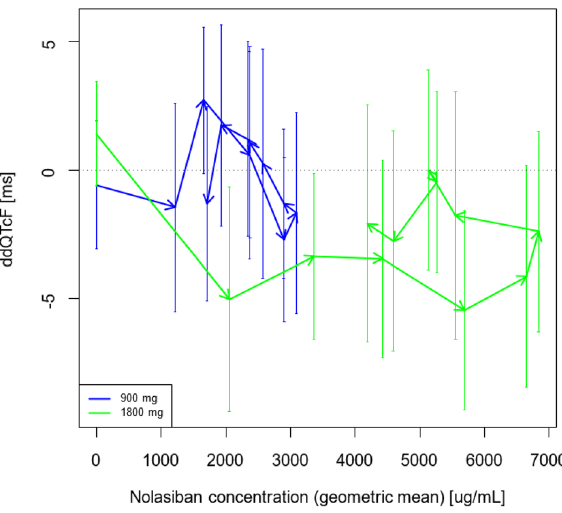
Figure 5. Hysteresis loops for 900 mg and 1800 mg nolasiban doses. There is no indication of any concentration related effect, and particularly not a delayed effect.